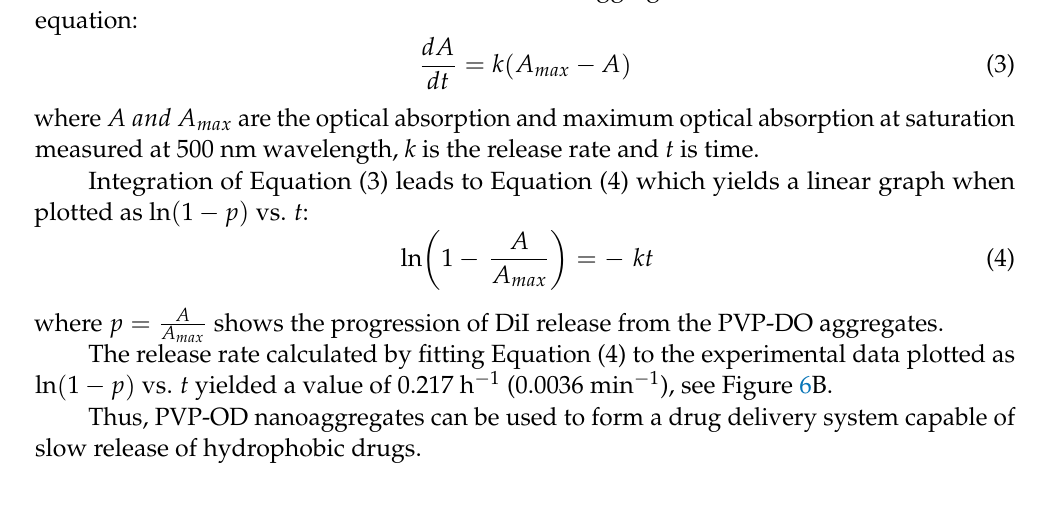
Figure 6. Release kinetics of DiI from nanosized PVP-OD aggregates: ( A ) time dependence of the DiI concentration in aqueous phase normalized to the maximum concentration. ( B ) Same data line- arized by plotting ln(1 − 𝑝) vs. t . Solid lines in both panels show a fit of the experimental data to a first order kinetic equation with a rate of 0.217 h -1 .